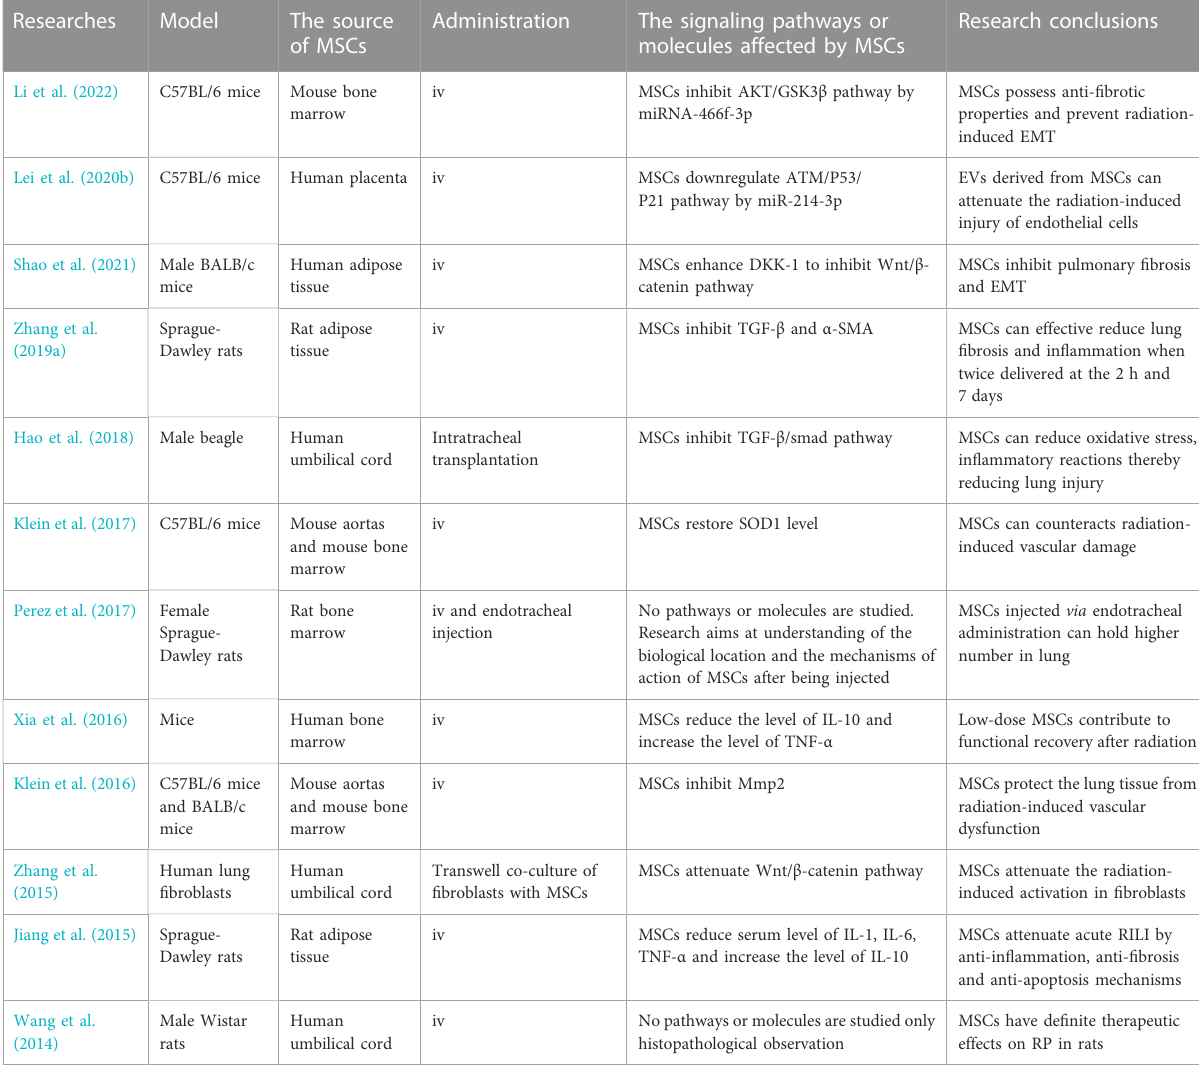
TABLE 1 Current and ongoing studies on direct administration of MSCs in